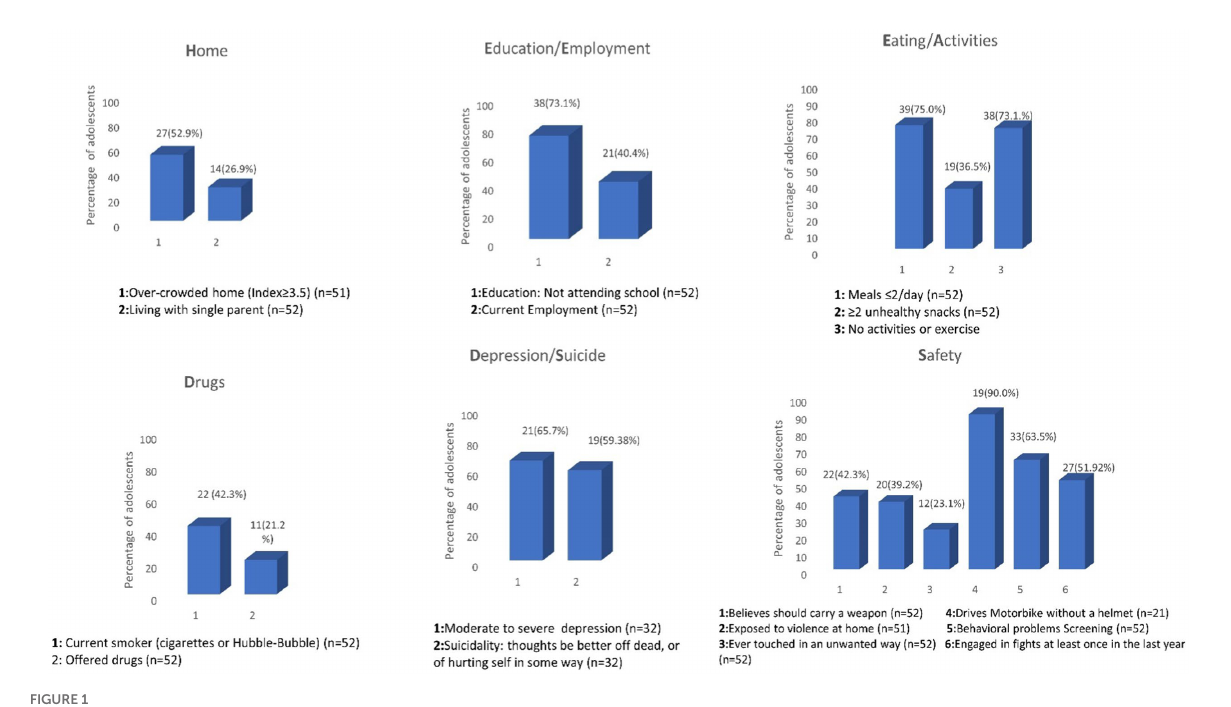
FIGURE 1 Risky health concerns/behaviors among 52 Syrian adolescent refugees displaced to South Beirut interviewed following the HEEADSSS framework ¥ —2019. ¥ We reported our findings as possibly similar to the table reported in the AAFP 2020 article reporting risky health behaviors among adolescent high school students in the US (Klein et al., 2020).